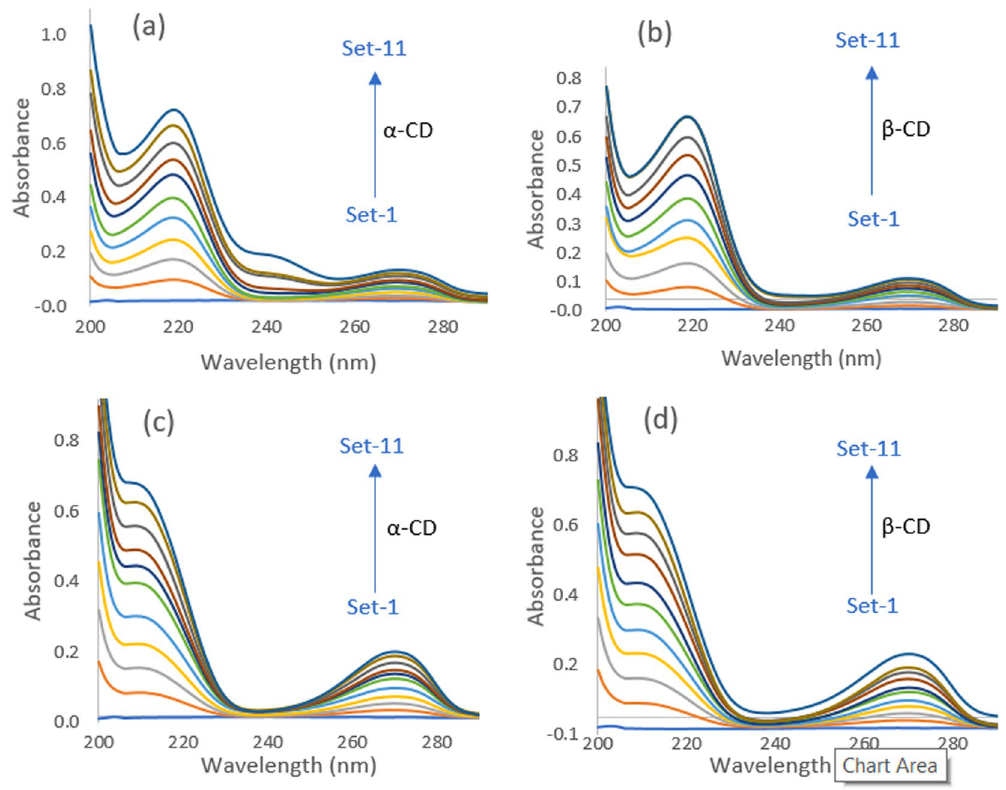
Figure 2. (a , b , c , d) UV-Vis spectra for the generation of Job plots of (a) SNP + α -CD and (b) SNP + β -CD systems at λ max = 209 nm, and (c) PEH + α -CD and (d) PEH + β -CD systems at λ